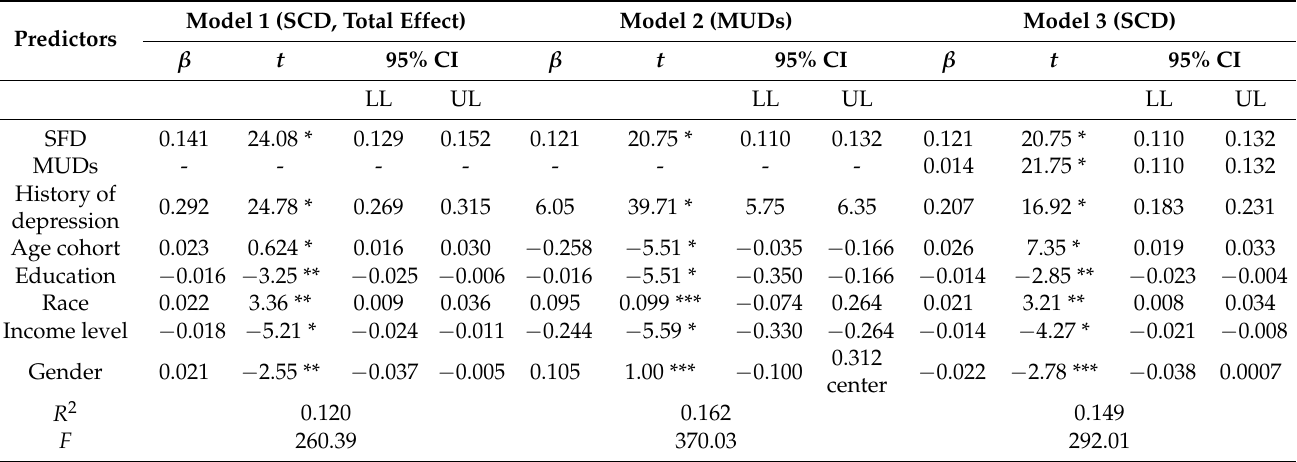
Table 2. Testing the mediation effect of mentally unhealthy days (MUDs) between subjective func- tional difficulties and SCD in the U.S., 2019.